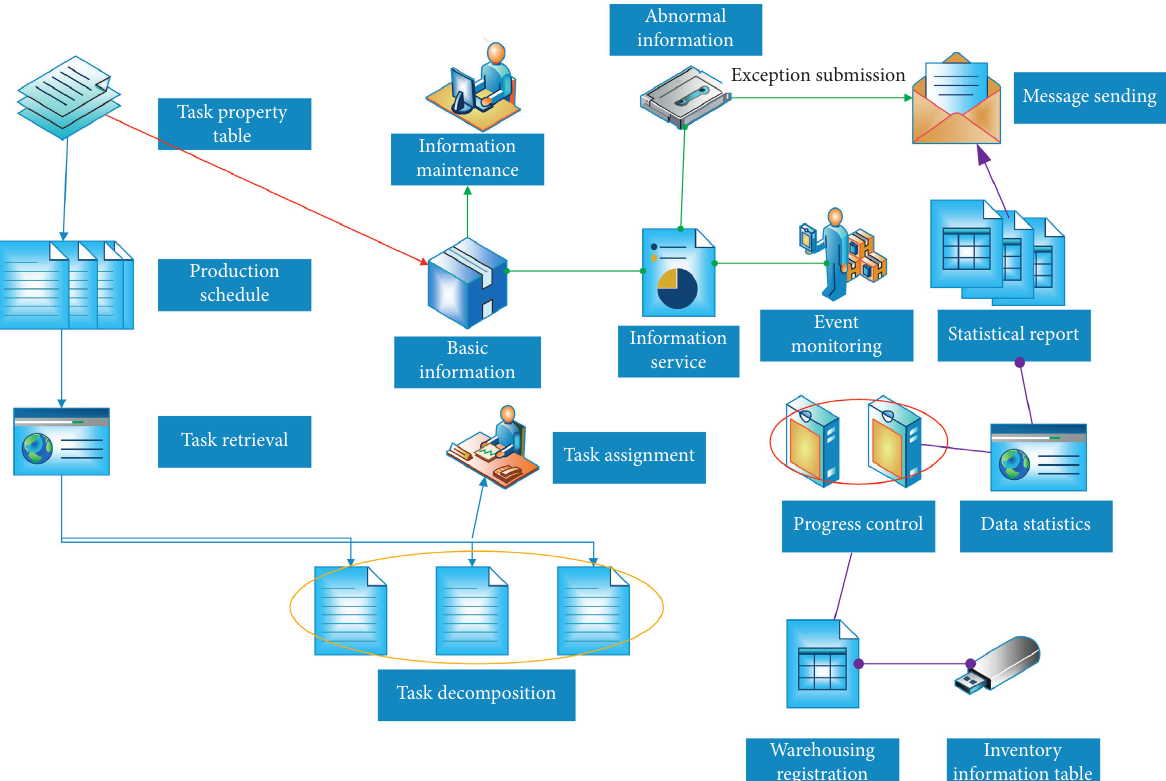
Figure 2: Initial class architecture of production task scheduling.